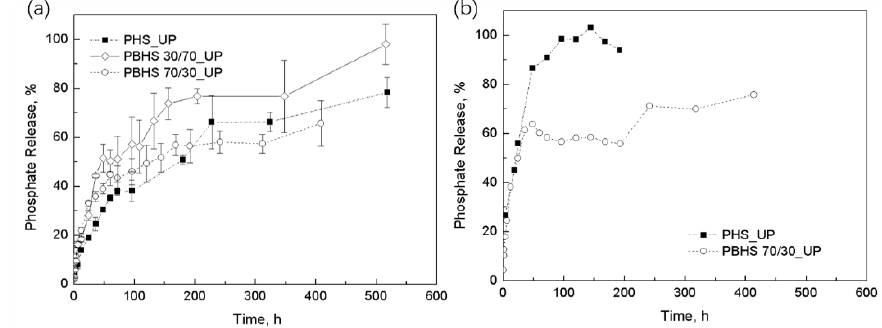
Figure 8. Accumulative phosphate release fraction for ( a ) UP-loaded PHS, PBHS 30/70, and PBHS 70/30 at 25 °C; ( b ) UP-loaded PHS and PBHS 70/30 at 37 °C.